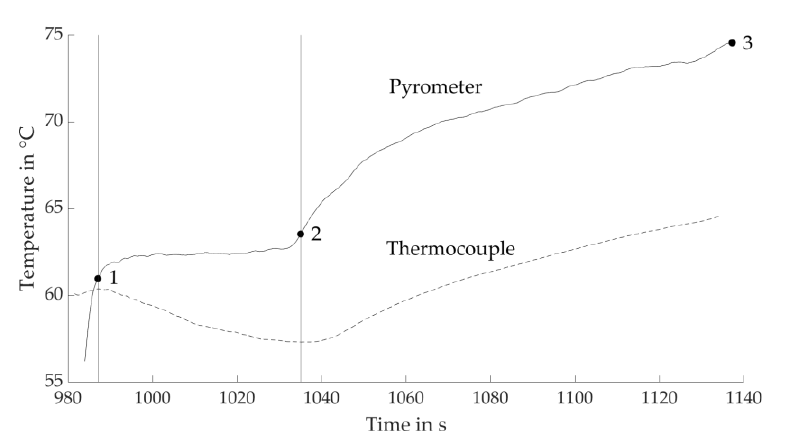
Figure 4. Determination of Drying Points 1 and 2 by comparing the temperatures measured by thermocouple and the pyrometer signal at an emissivity of 1 (digital values) and Layer 5. The signals are recorded in the parameter sets with Drying Point 3 corresponding to the estimated boundary of the process window. Drying Point 1 corresponds to the local maximum measured by thermocouple, Drying Point 2 to the local minimum. Exemplary for PAV = 3.4 V at a layer height of 100 µm.